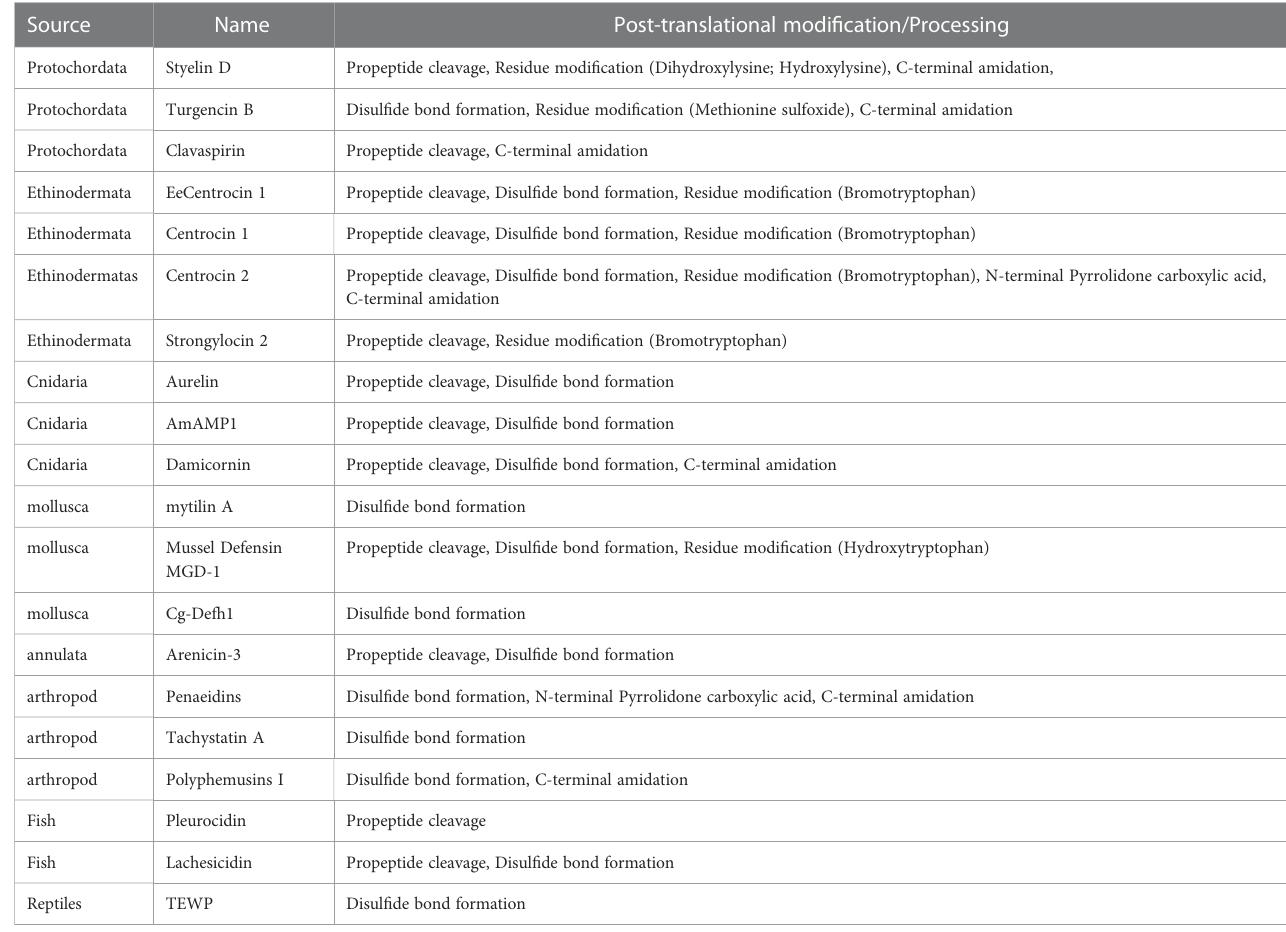
TABLE 1 The post-translational modi fi cations and processing of marine AMPs from different sources. Source